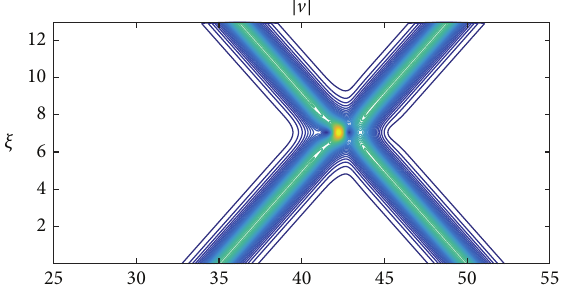
Figure 16: Collision of coupled-mode solitons with 𝜙 1 = 𝜋 and 𝜙 2 = 0